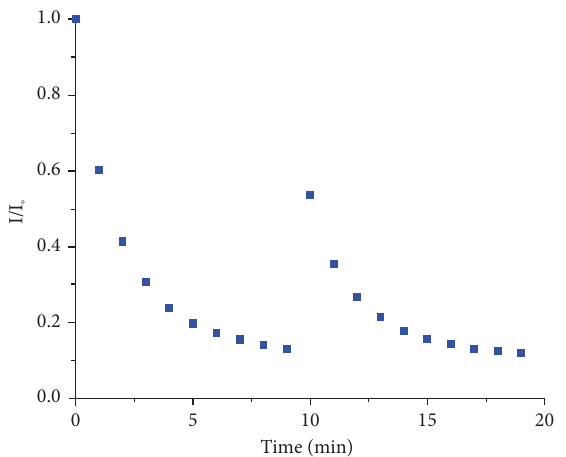
Figure 2: Fluorescence recovery after photobleaching of a 1mg · m − 1 solution of BSA in water. Te values of the fuorescence intensity were expressed relative to the initial